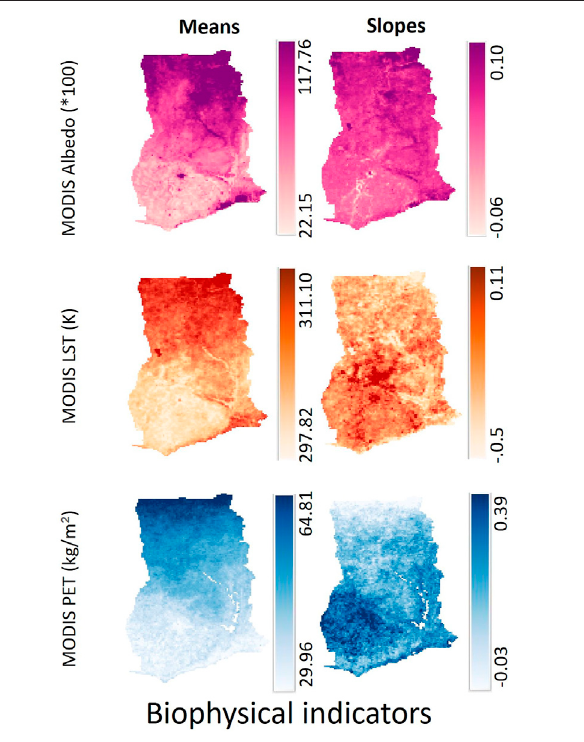
FIGURE 4 | Spatial variations in means and trends of MODIS-derived biophysical variables. Note albedo is dimensionless. Data sources presented in Table 1